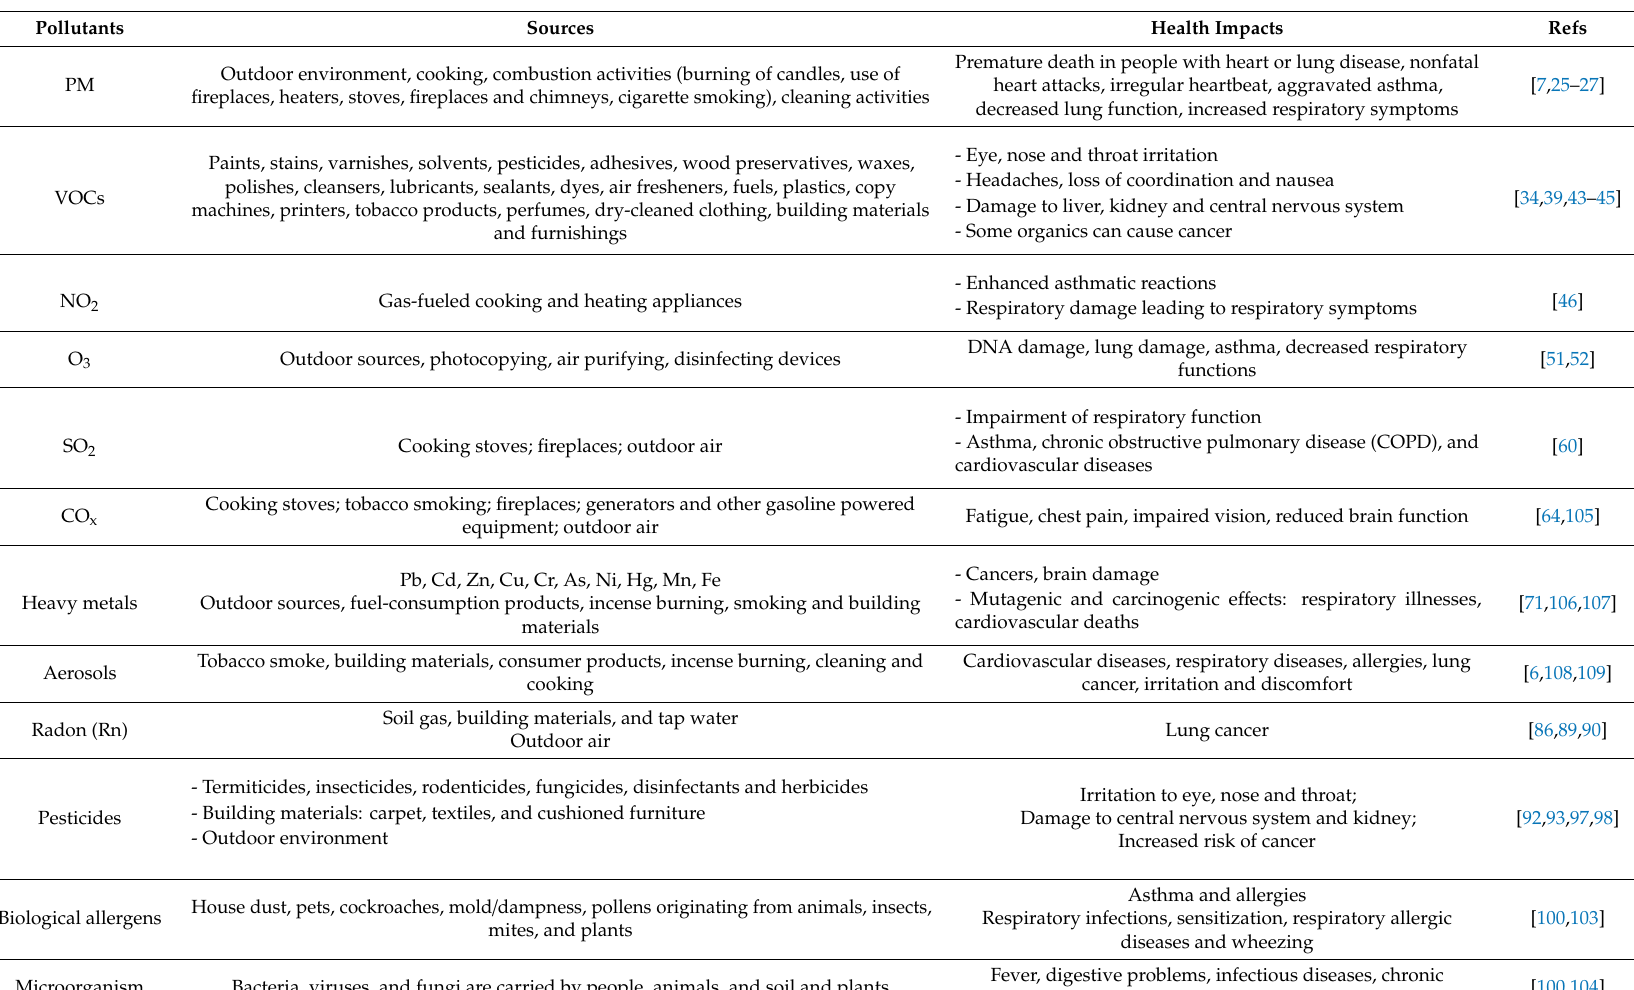
Table 1. Common indoor pollutants and their e ff ects on human